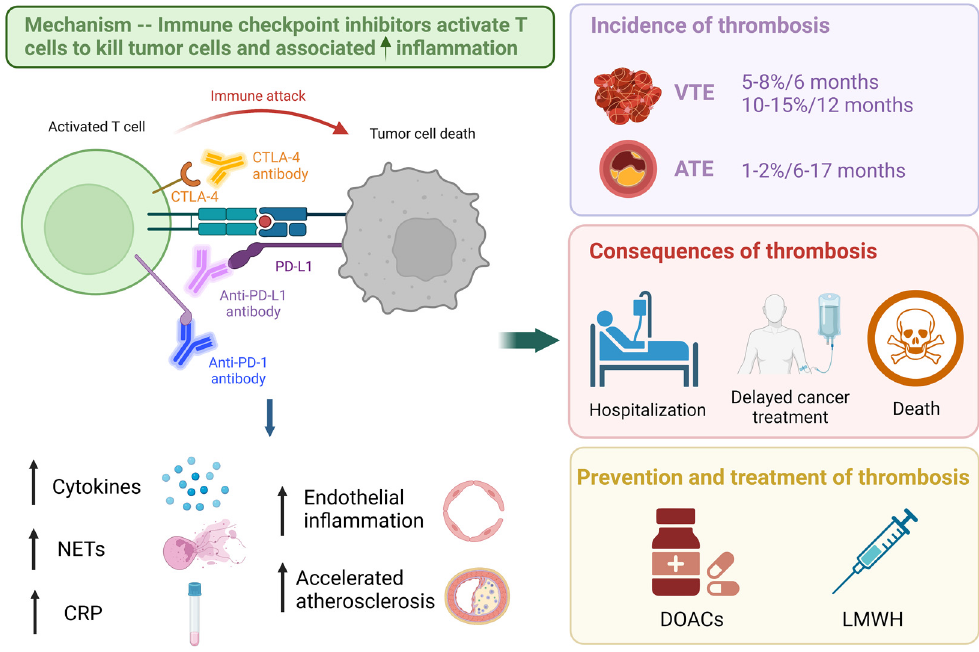
Figure 1. Summary of mechanism, incidence, consequences, prevention, and treatment of immune checkpoint inhibitor-associated thrombosis. Figure was created with BioRender.com and adapted from “Immune Checkpoint Inhibitor Against Tumor Cell”, by BioRender.com (2023). Retrieved from https://app.biorender.com/biorender-templates (accessed on 2 February 2023).